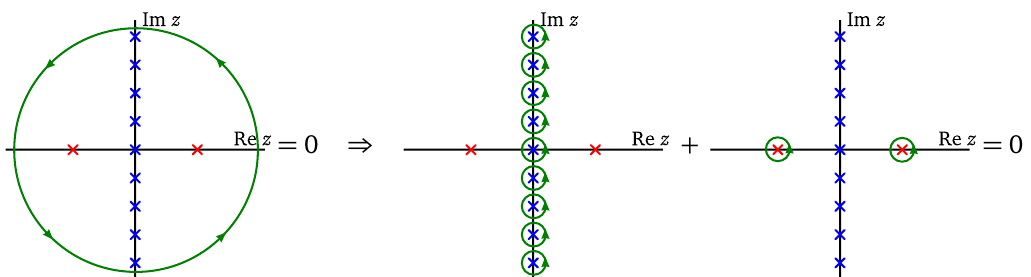
Figure 4.1: The contour integrals used in evaluating the sum over Matsubara fre- quencies, for a propagator with two poles on the real axis. The integral over the contour at infinity on the left hand side vanishes because normalisability requires all fields to decay sufficiently fast as they approach infinity. The contour may be de- formed, however, into a sum over small contours surrounding all of the poles. This implies the equality on the right hand